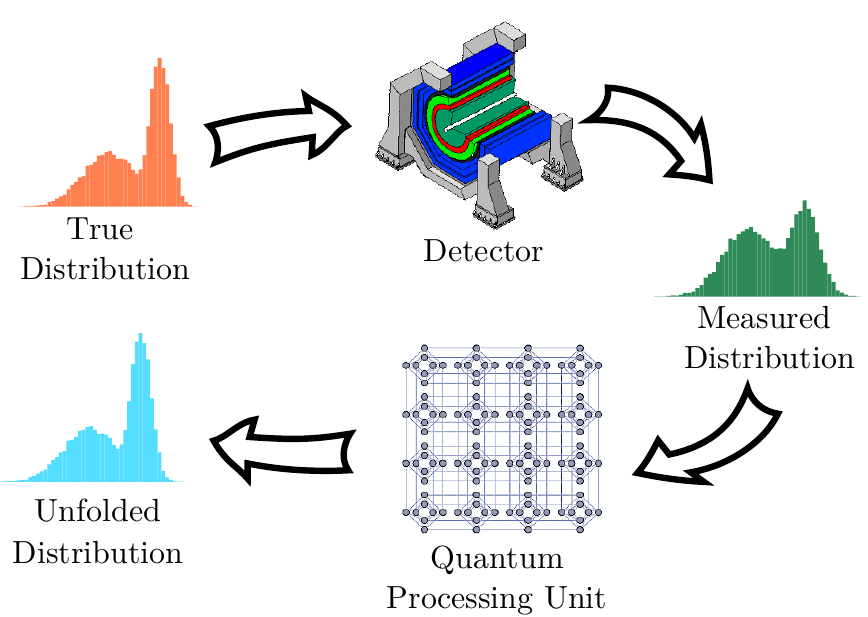
Figure 1 . The unfolding procedure corrects measured distributions, removing distortions caused by the detector. Here, we implement unfolding on a quantum computer